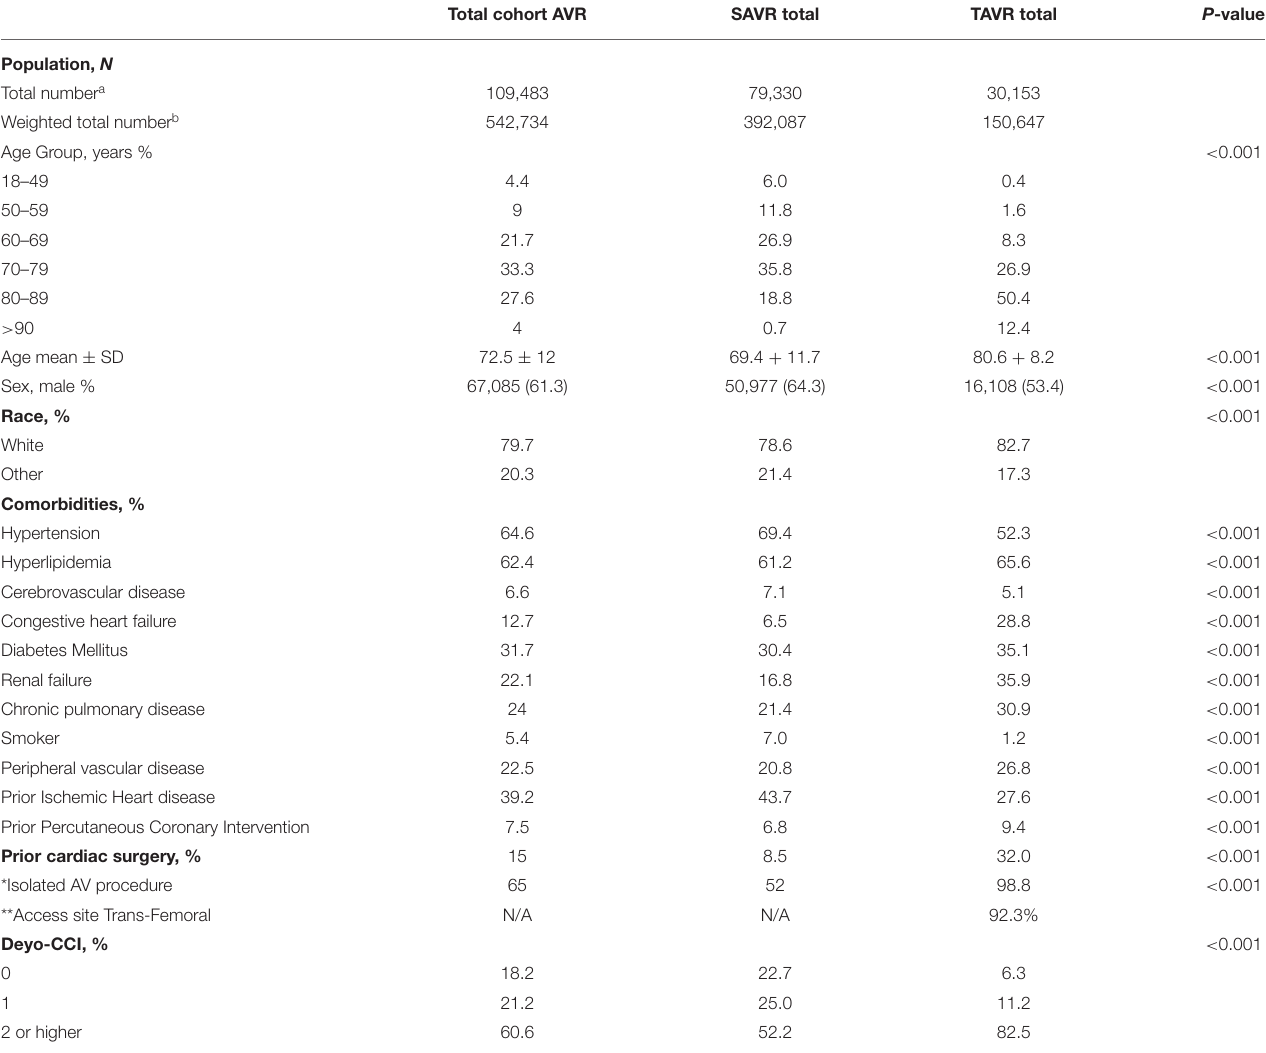
TABLE 1 | Comparison of baseline characteristics of SAVR vs. TAVR during the years